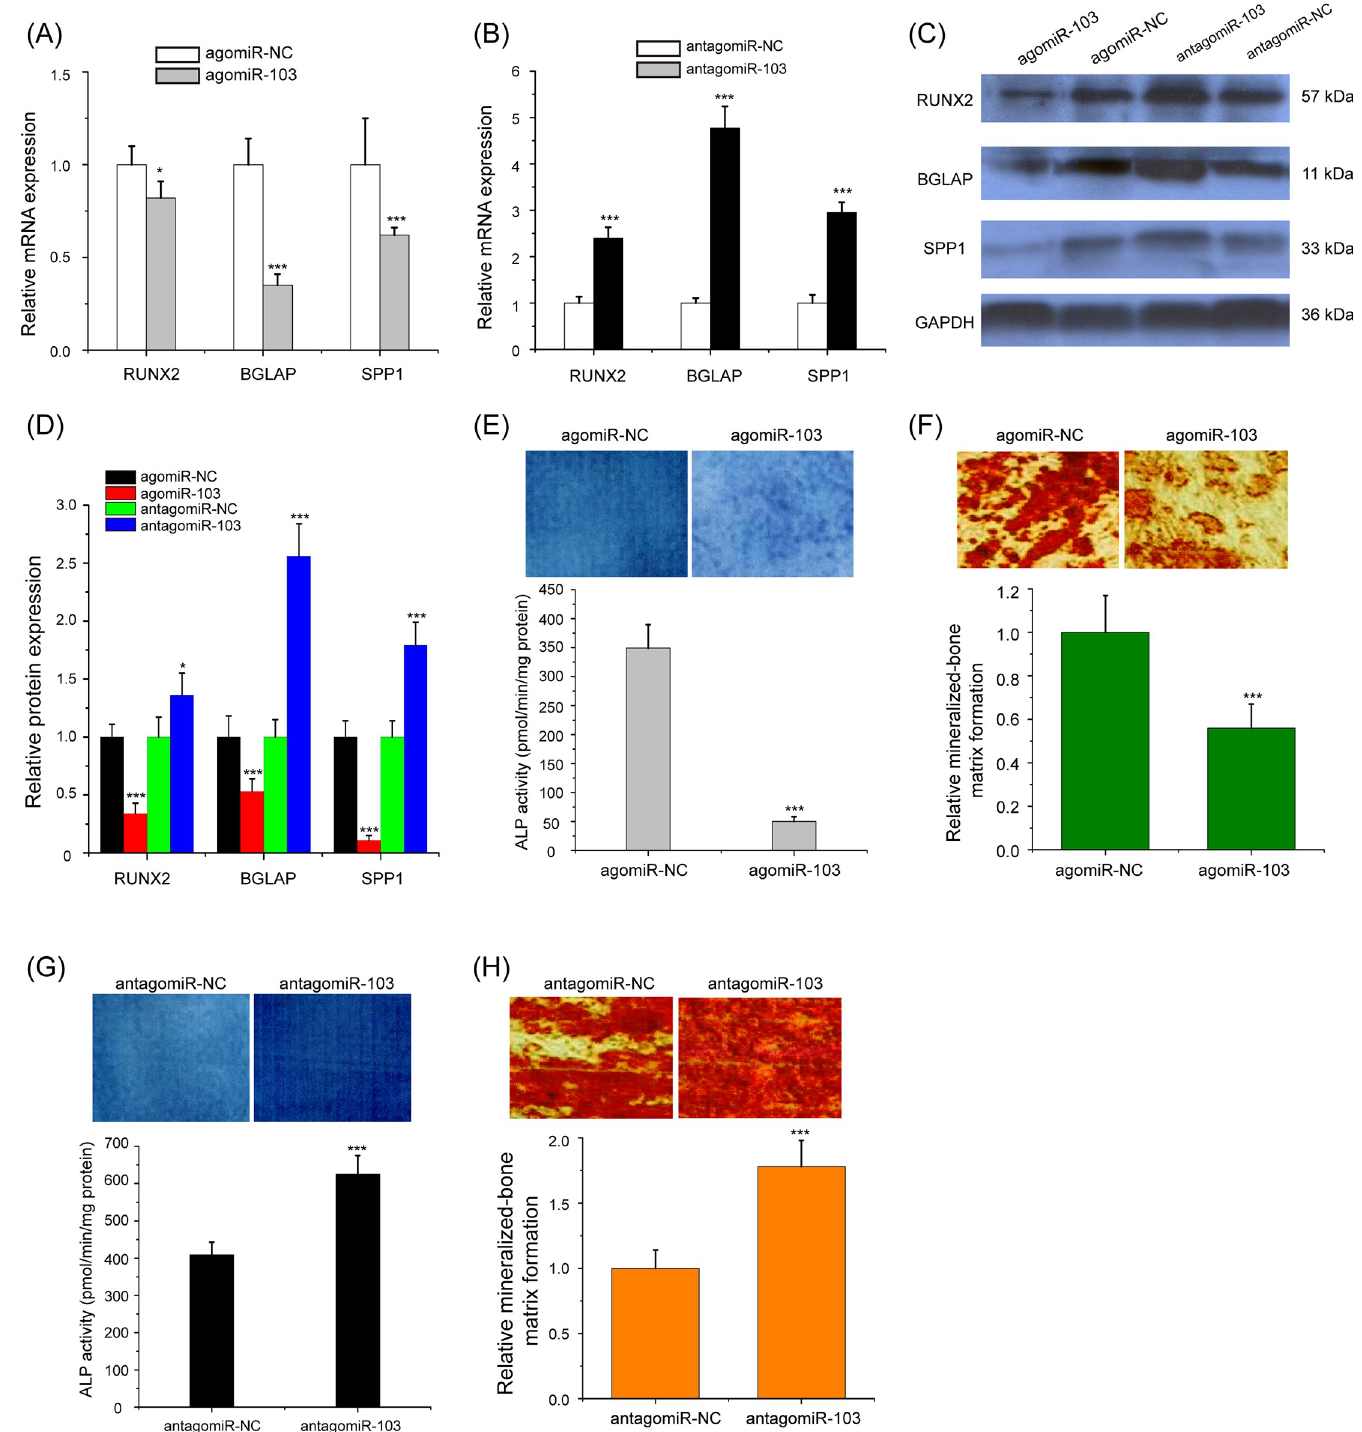
Fig 3. miR-103 represses the osteogenic differentiation of HBMScs. (A) Real-time qPCR analysis detected mRNA expression of RUNX2 , BGLAP and SPP1 in HBMScs after treatment with agomiR-103 or agomiR-NC. (B) The RUNX2 , BGLAP and SPP1 mRNA expression were significantly increased in the antagomiR-103 treated HBMScs. (C and D) Western blot analysis of the protein expression of RUNX, BGLAP and SSP1 in HBMScs by miR-103 overexpression and knockdown. (E) The ALP activity of HBMScs was significantly suppressed when miR-103 was overexpressed. (F) The osteogenic differentiation of HBMScs transfected with agomiR-103 and agomiR-NC was observed by Alizarin red S staining. (G) Knockdown of miR-103 exhibited higher ALP activity after osteogenic differentiation of 21 days. (H) Alizarin red S staining investigated the ability of mineralized-bone matrix formation in HBMScs treated with antagomiR-103 or antagomiR-NC. Columns mean of three independent experiments. � p < 0.05, ��� p <